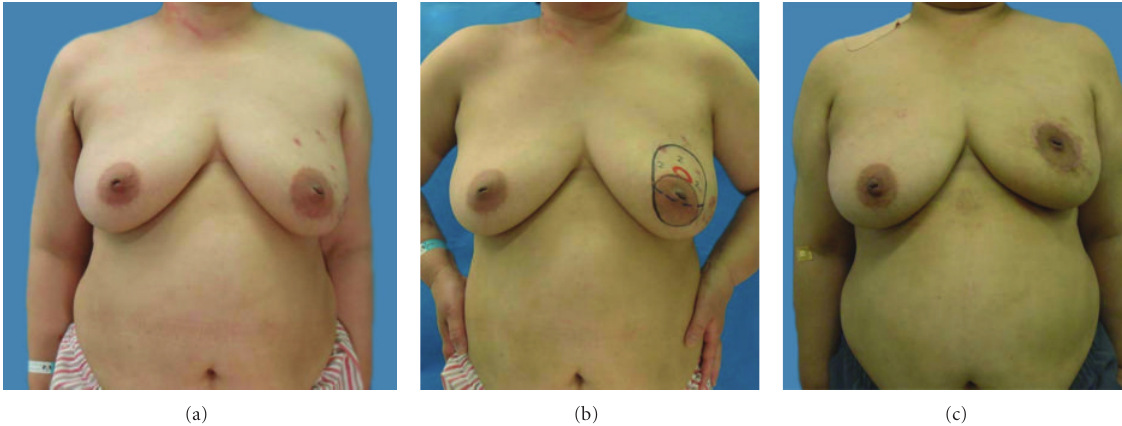
Figure 5: Case 2 . a 51-year-old patient with a T1 tumor in the periareolar area of her left breast. (a) Her breasts were ptotic and large. (b) Lesions were detected by ultrasonography with the patient in a supine position. A 2cm surgical margin (black circle) was drawn around the cancer lesion (red circle). No contralateral procedure was planned. (c) Postoperative 6